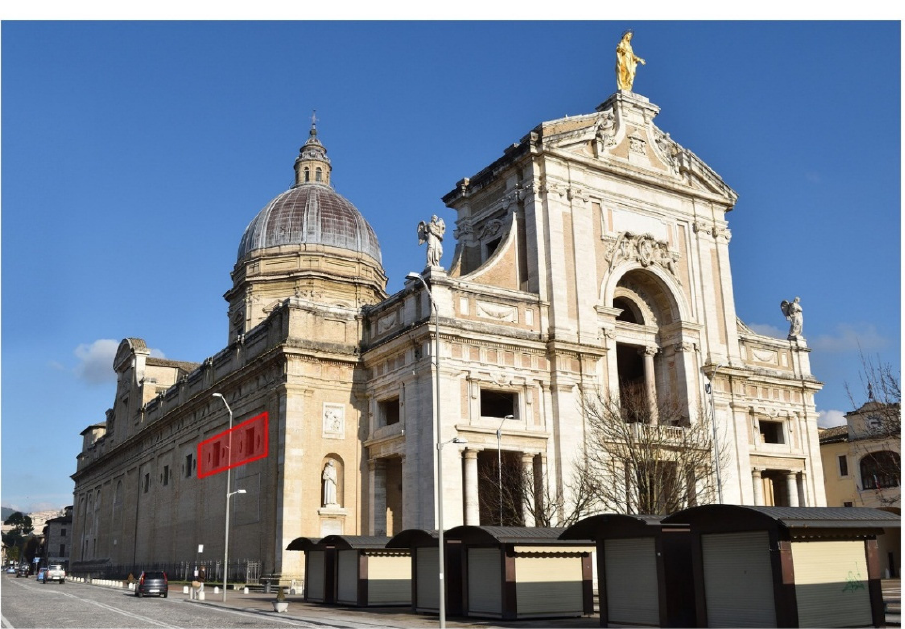
Figure 8. Image of the Basilica of Santa Maria degli Angeli in Assisi; position of buttresses located above the lateral aisles.